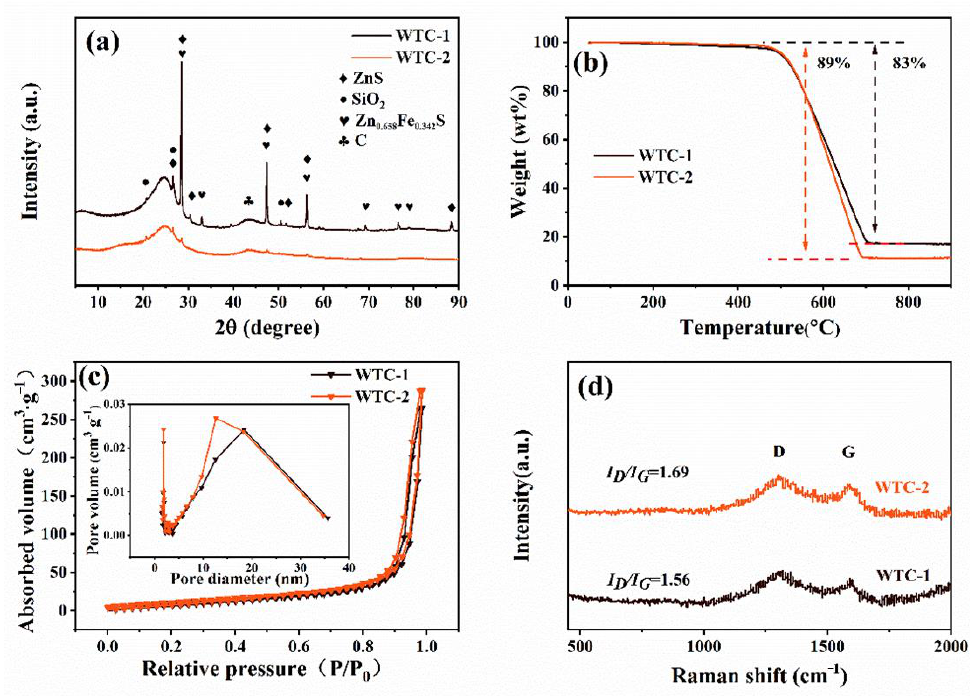
Figure 1. XRD patterns ( a ); TGA curves ( b ); N 2 adsorption-desorption plots; ( c ) and Raman spectra ( d ) of the prepared materials WTC-1 and WTC-2. ( d ) of the prepared materials WTC-1 and